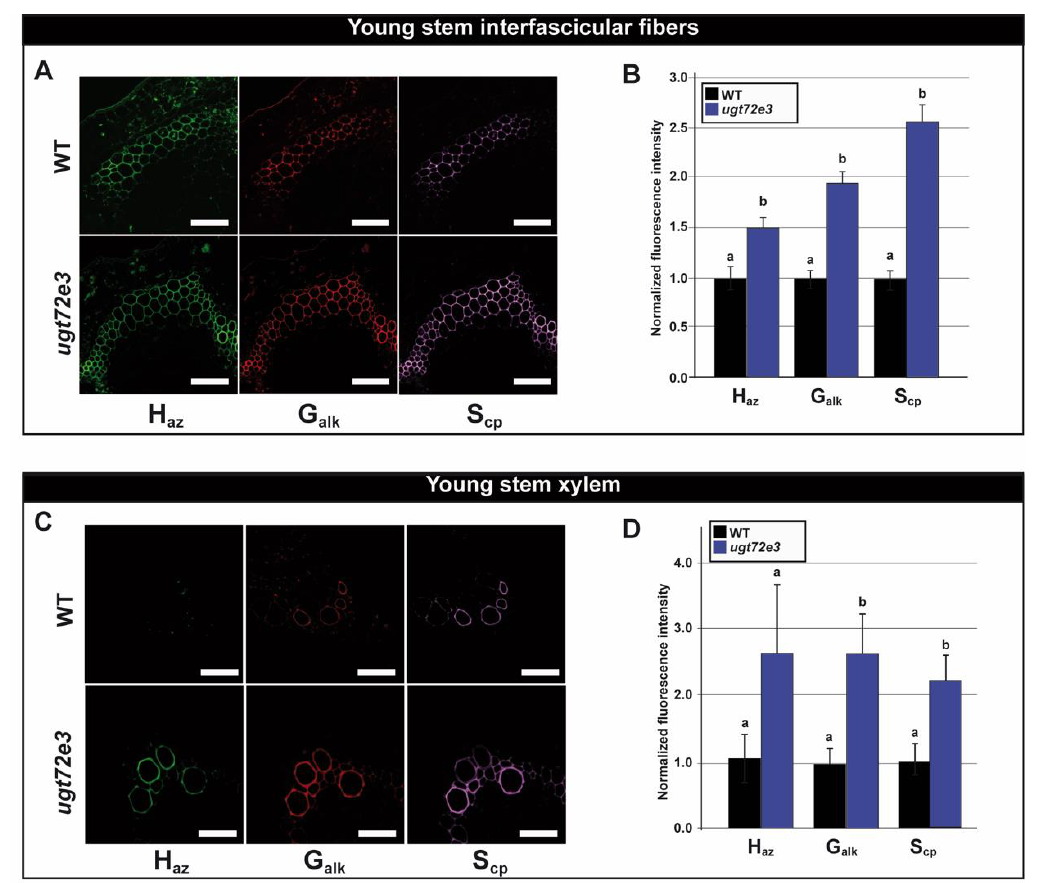
Figure 7. Monolignol incorporation capacity in the young part of the floral stem. The capacity of cell walls to incorporate monolignols into cell walls was evaluated by measuring the signal of fluorescent probes bound to monolignol chemical reporters metabolically incorporated into the lignin polymer. The tagged monolignol associated incorporation signal was localized in the interfascicular fibers and xylem cell walls ( A , C ). H az tagged lignin reporter unit signal appears in green, G alk in red and S cp in purple. Scale bar = 50 µ m. The associated incorporation signal was quantified in ugt72e3 and compared to the WT ( B , D ). Means ( ± SD) with the same lowercase letters are not significantly di ff erent according to Student t -test ( p -value < 0.01, n = 3).